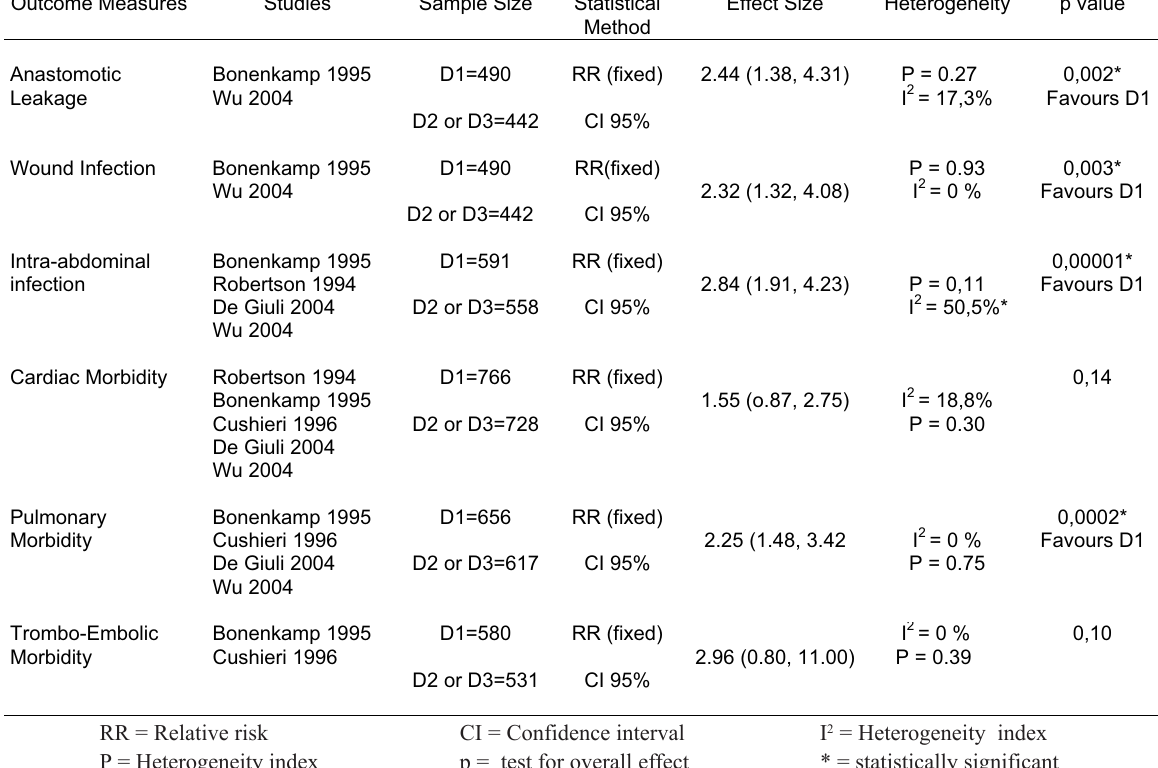
TABLE 2 – Summary of the meta-analysis results of morbidity